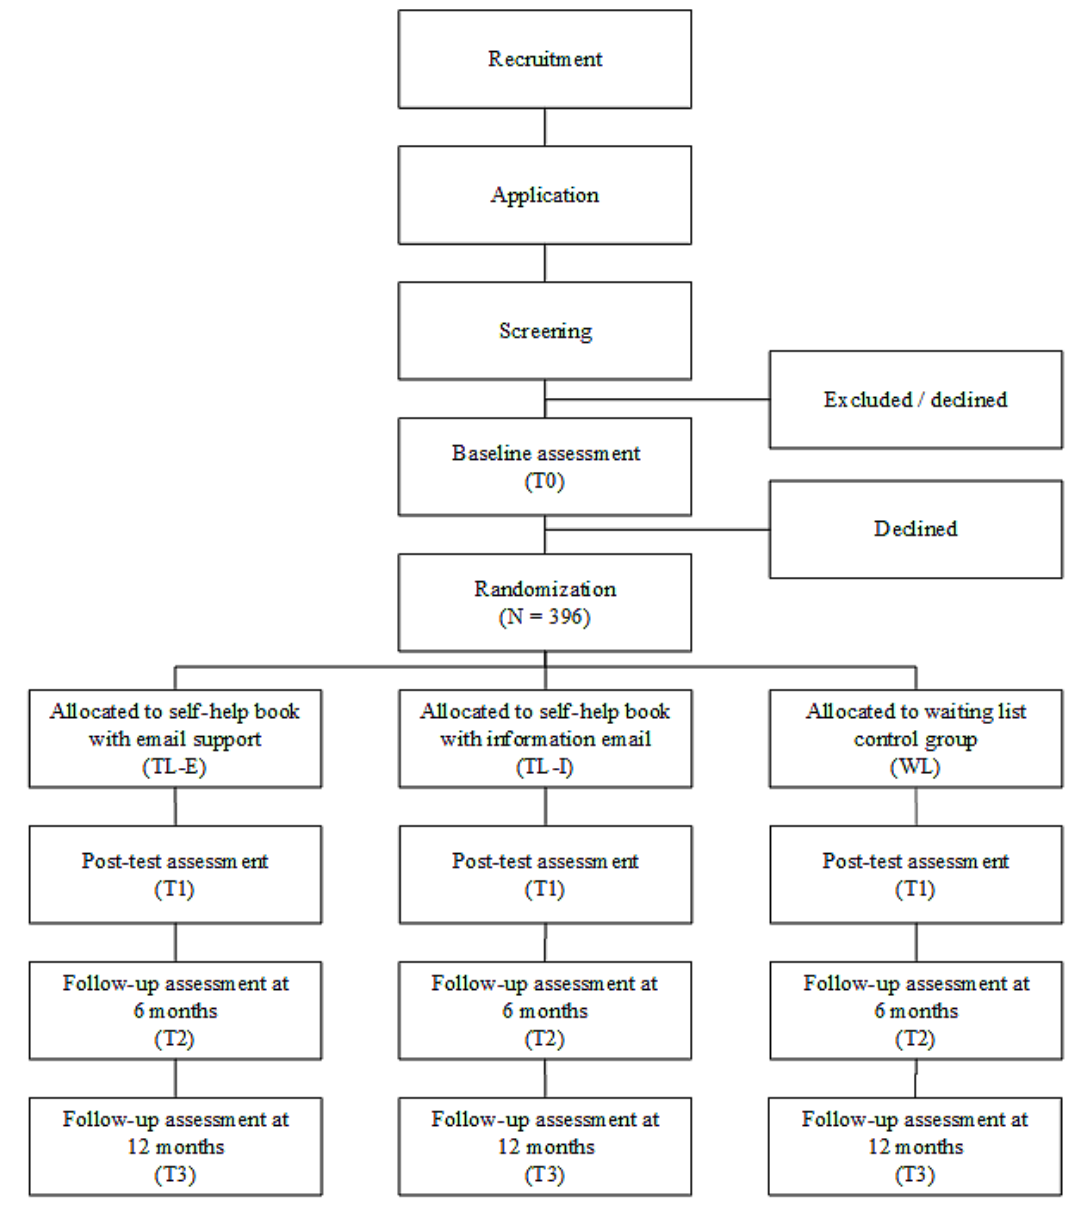
Figure 1. Design of the study and intended flow-chart of